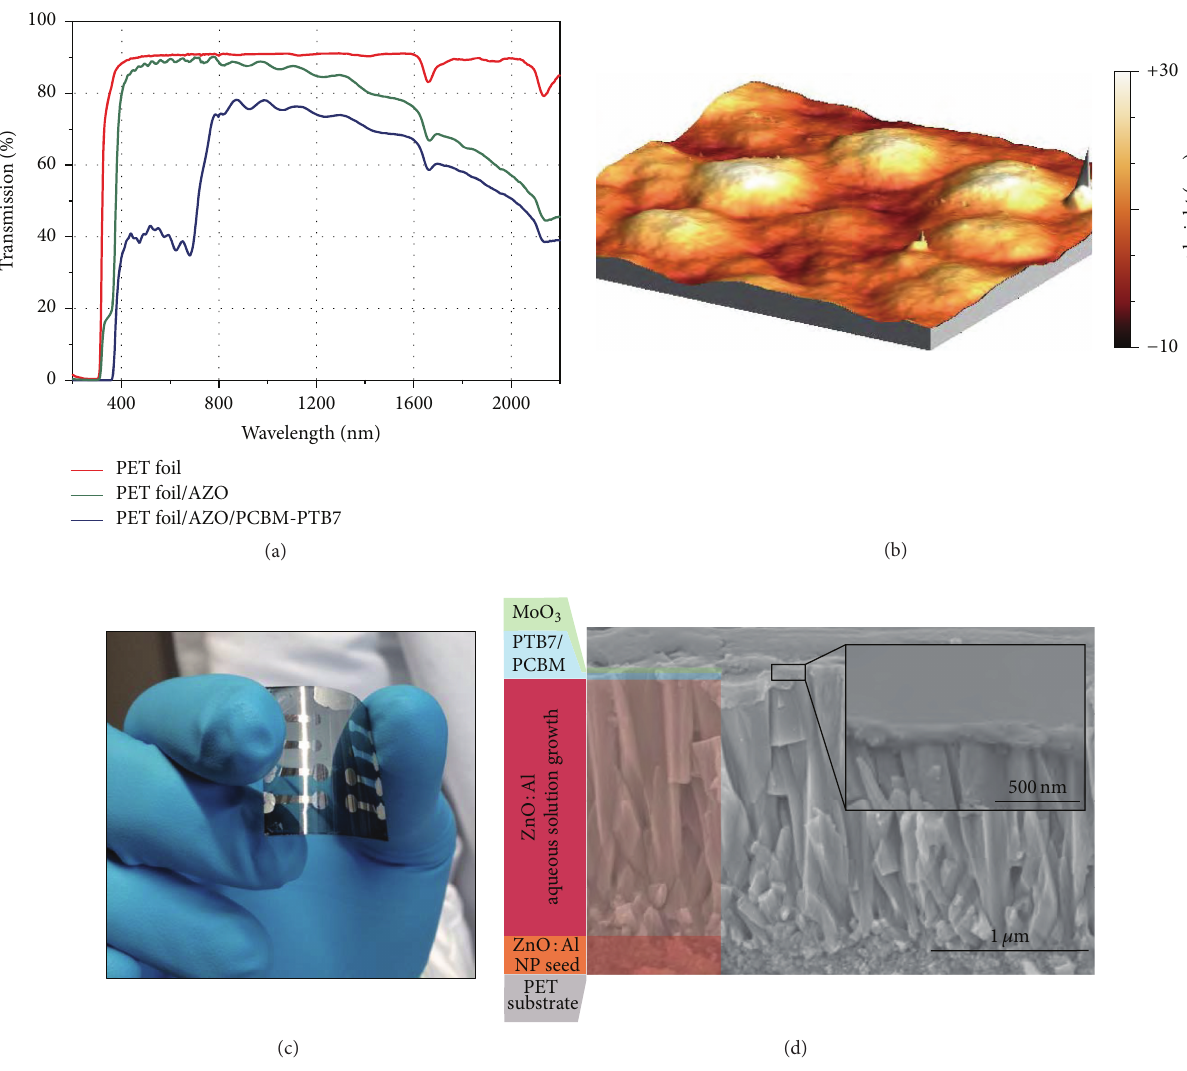
Figure 2: (a) UV-Vis transmission spectrum of CBD-AZO on PET and of the photoactive layer on CBD-AZO. (b) AFM topography measurements of an AZO layer on PET foil (2 × 2 𝜇 m). (c) Photograph of solar cells with solution-processed AZO on PET polymer foil substrate. (d) SEM cross section of the device on PET